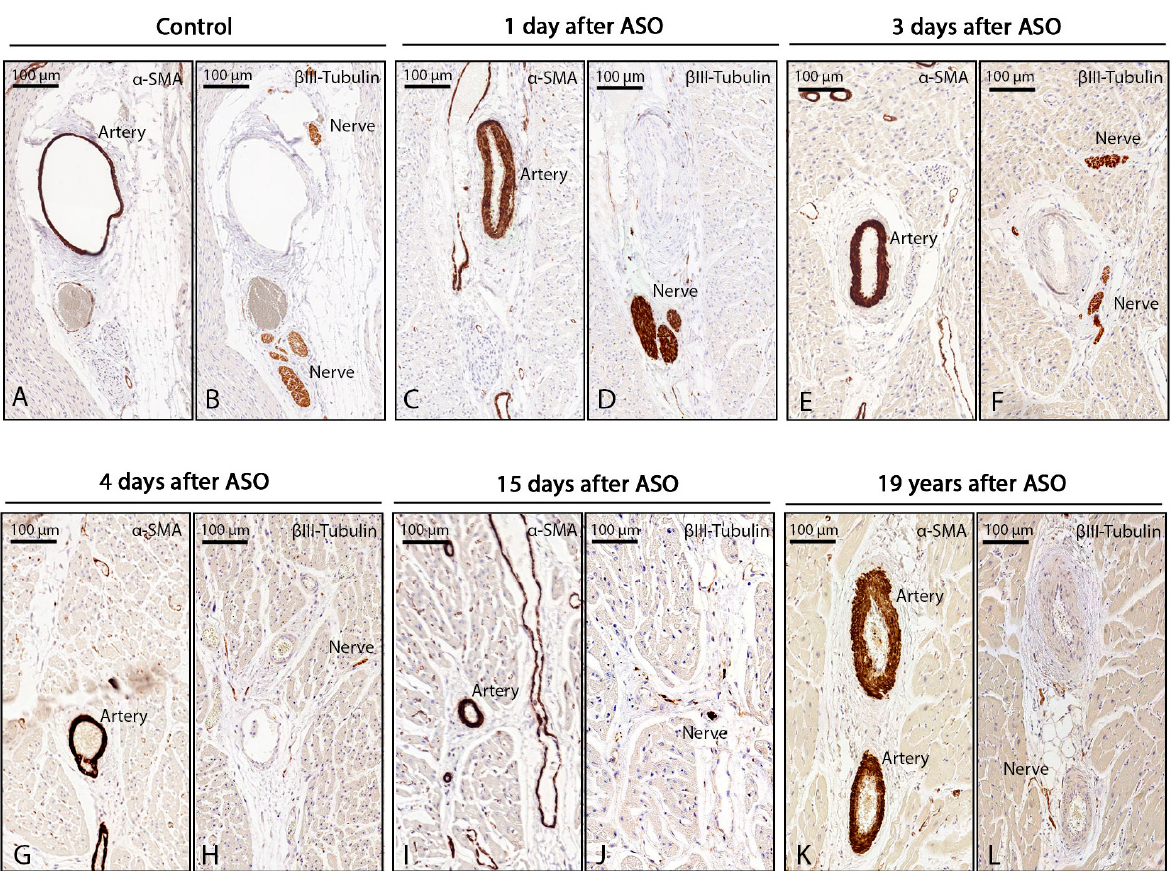
Figure 6. Myocardial innervation in uncorrected TGA and TGA-ASO. Myocardial innervation in uncorrected TGA and after ASO. Innervation post-ASO was evaluated in carefully matched sections in areas with cross-sectioned coronary vessels and compared between controls and TGA-ASO specimens. Visualization of cross-sectioned arteries and veins was performed by α -SMA staining ( A , C , E , G , I , K ). Innervation staining: ( B ) β III-tubulin-positive nerves around coronary arteries and veins in uncorrected TGA. ( D ); postmortem hearts that survived 1 day after ASO showed β III-tubulin-positive nerves, the uptake was comparable to the control specimen. ( F,H,J,L ); reduced uptake of β III-tubulin around cross-sectioned coronary vessels after 3 days, 4 days, 15 days, and 19 years after ASO. Abbreviations: ASO, arterial switch operation; TGA, transposition of the great arteries; α -SMA, α smooth muscle actin.